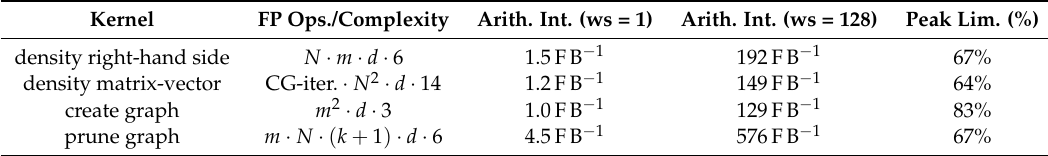
Table 1. The number of floating-point operations for the different OpenCL kernels and the arithmetic intensities (in floating point operations per byte) for a work-group size (ws) of one thread and 128 threads. The peak limit states the achievable fraction of the peak performance given the instruction mix of the computed